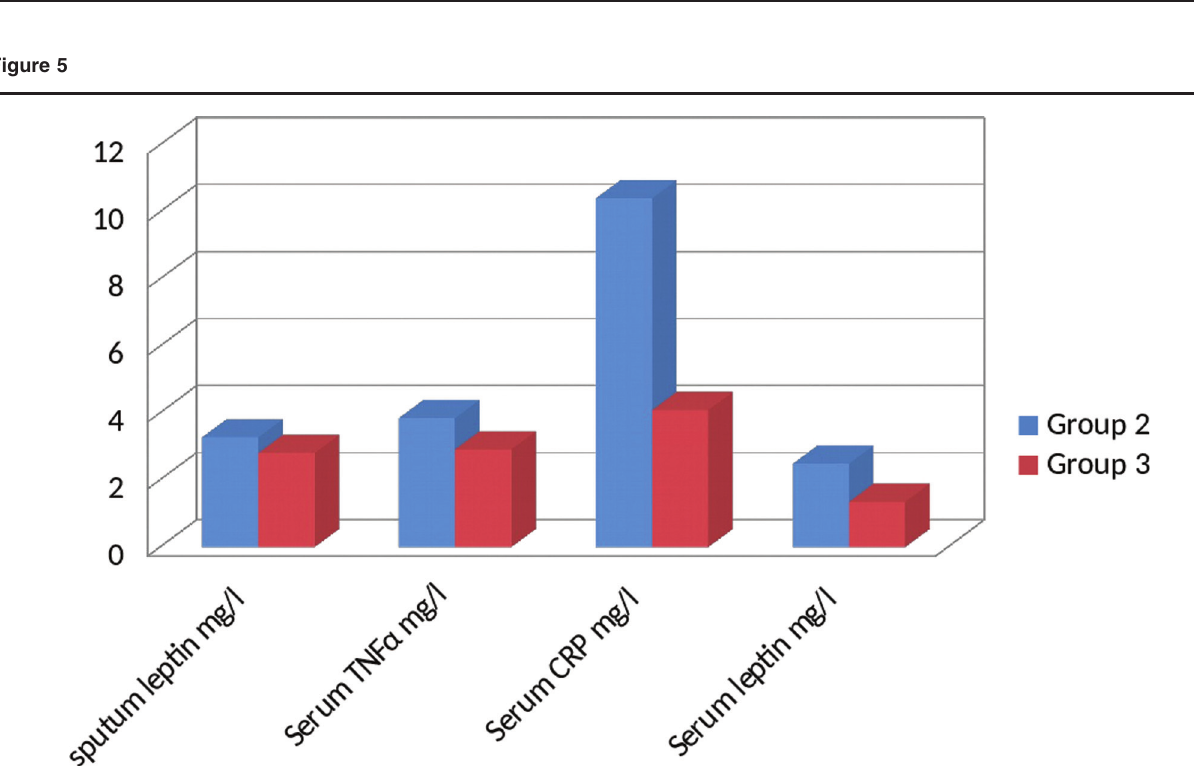
Correlation between sputum leptin, serum TNF- α , CRP, and leptin levels within group 2 and group 3. CRP, C-reactive protein; TNF- α , tumor necrosis